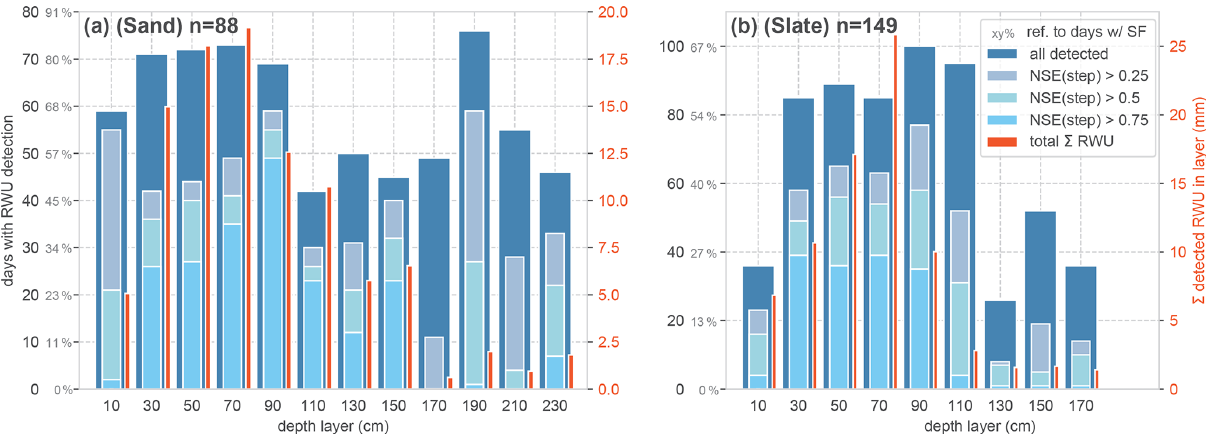
Figure 7. Qualitative evaluation of the RWU derivation algorithm for the sand (a) and the slate site (b) . The reference n is the number of days with a SF > 0.1Ld − 1 . The dark blue bars refer to the number of days with a successful RWU detection, according to the general step criteria. Their proportion of the reference SF days is given in the grey percentages on the y axes. The lighter blue colour reports the compliance of the detected RWU, with the ideal step shape assessed with the NSE, as a respective subfraction of the total dark blue bar height. For comparison with the magnitude of the detected RWU in each layer, the total sum of RWU over the entire season is given as red bars.